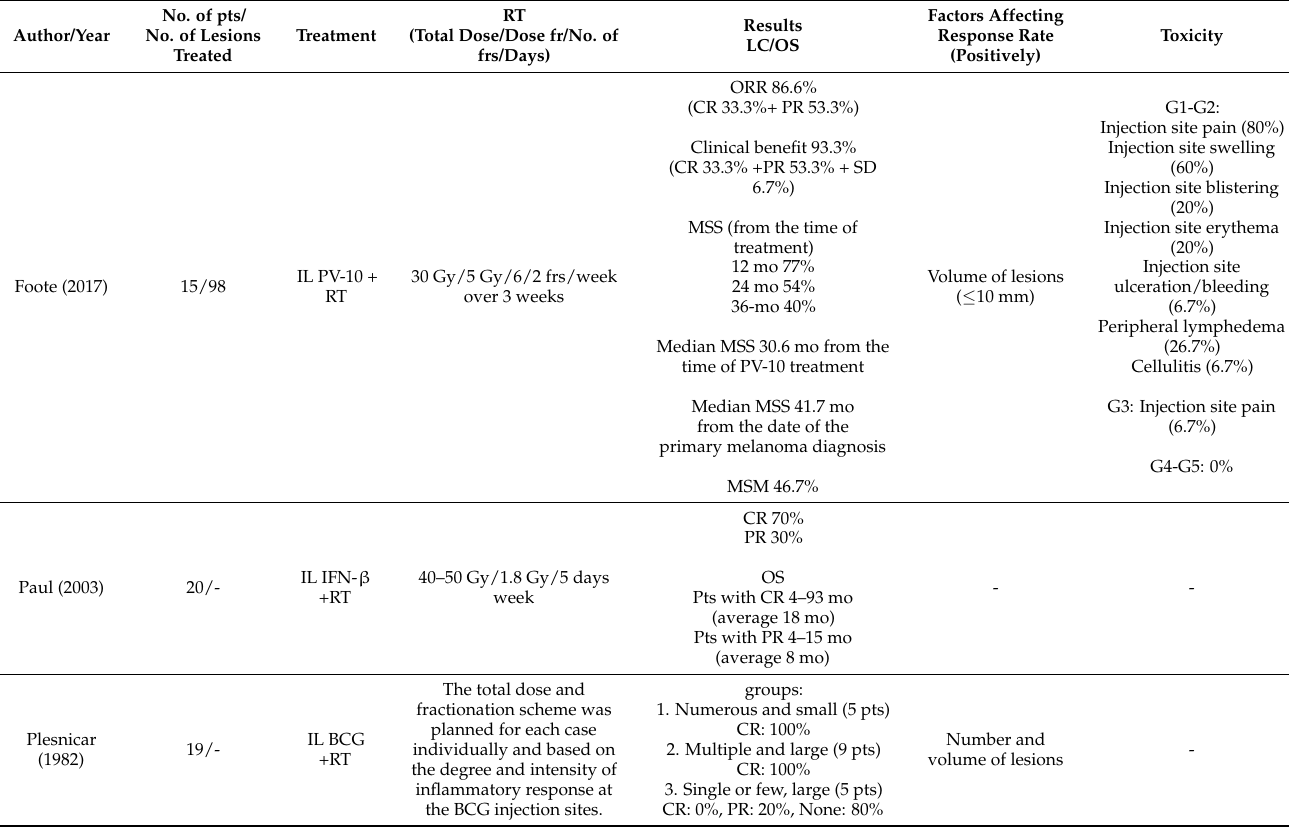
Table 2. Studies of radiotherapy in combination with intralesional melanoma lesion